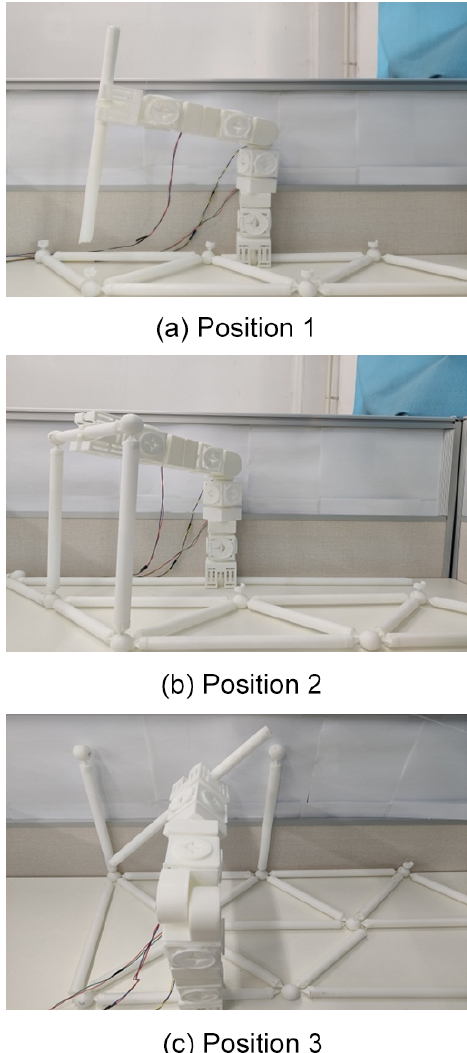
Figure 14. Truss assembly diagram.